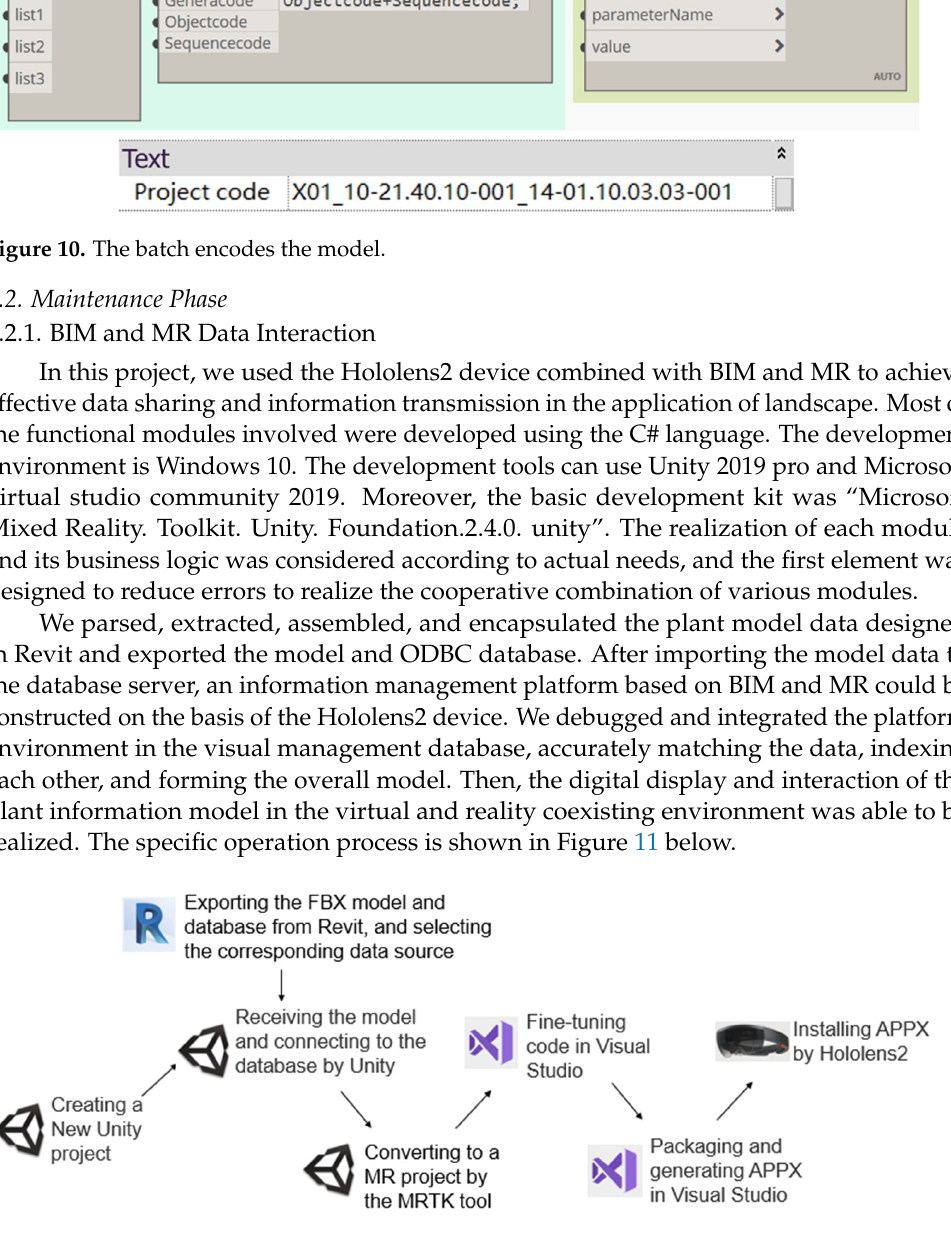
Figure 12. On-site model information display. 4.2.2. Collaborative Communication In this project, we used BIM and MR for achieving accurate transmission of multi- dimensional model information and the collaborative communication of the model by multiple parties in virtual space. Multiple designers can simultaneously observe the three- dimensional effect of the landscape after the planting of plants in advance and visualize